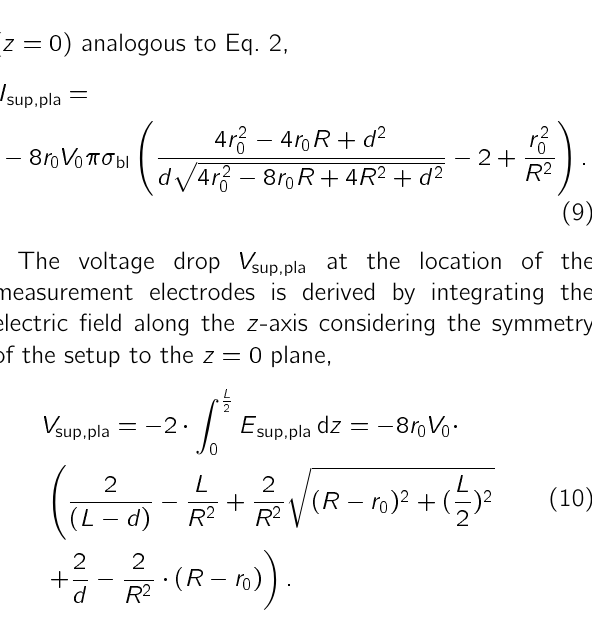
Figure 2: Electric field distribution by applying the voltages (red) on a sphere and V 0 V = +V 0 on a spare 0 0 (cid:0) charge plate (blue). The measurement electrodes (green) are distanced by L . Muscle tissue ( (cid:27) ) with a thickness m of b and background tissue ( (cid:27) ) are ba